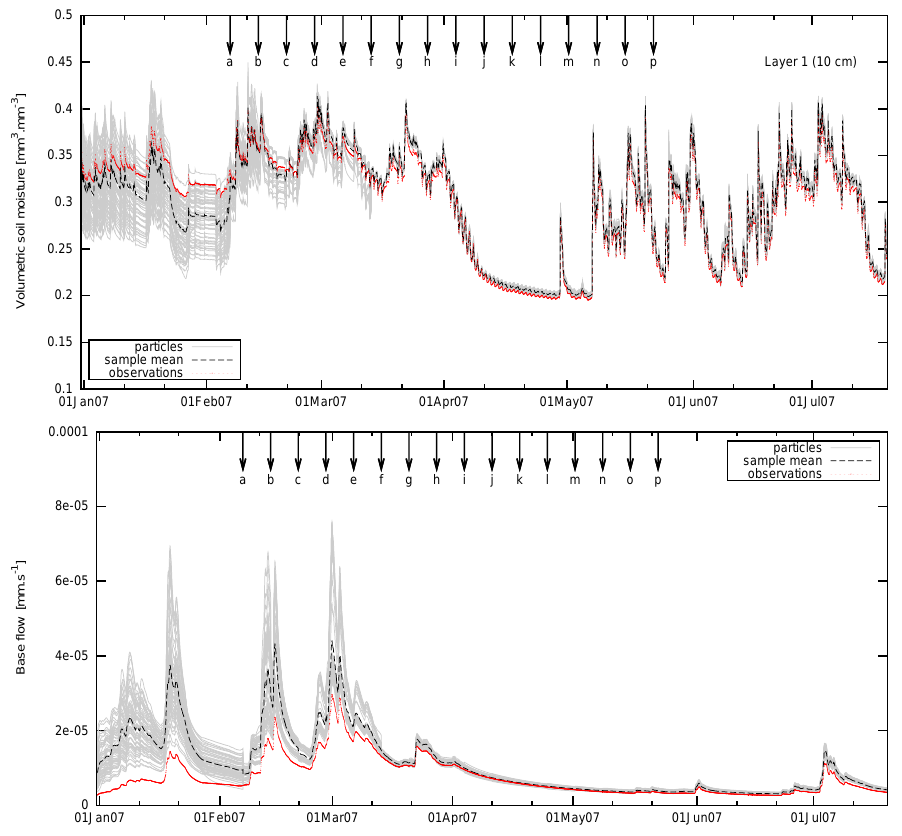
Fig. 6. SISR-PR filter performance and assimilation impact on the baseflow without parameter perturbation. The soil moisture and baseflow time series correspond to the DA study performed with set 2 as the initial parameter set. Table 4. RMSE [mm 3 · mm − 3 ] between the observed and simulated soil moisture for 3 DA frequencies.